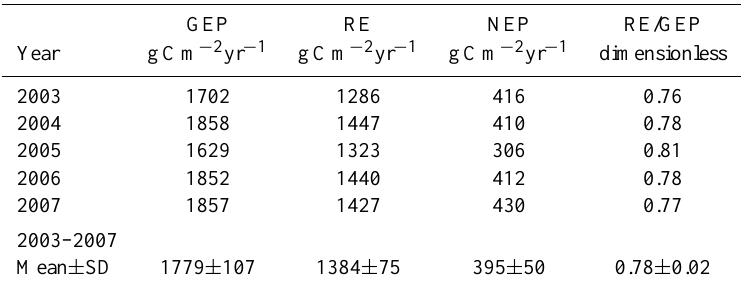
Table 2. Interannual variability in annual gross ecosystem photosynthesis (GEP), ecosystem respiration (RE), net ecosystem production (NEP) and the RE/GEP ratios from 2003 to 2007 at Qianyanzhou site. GEP RE